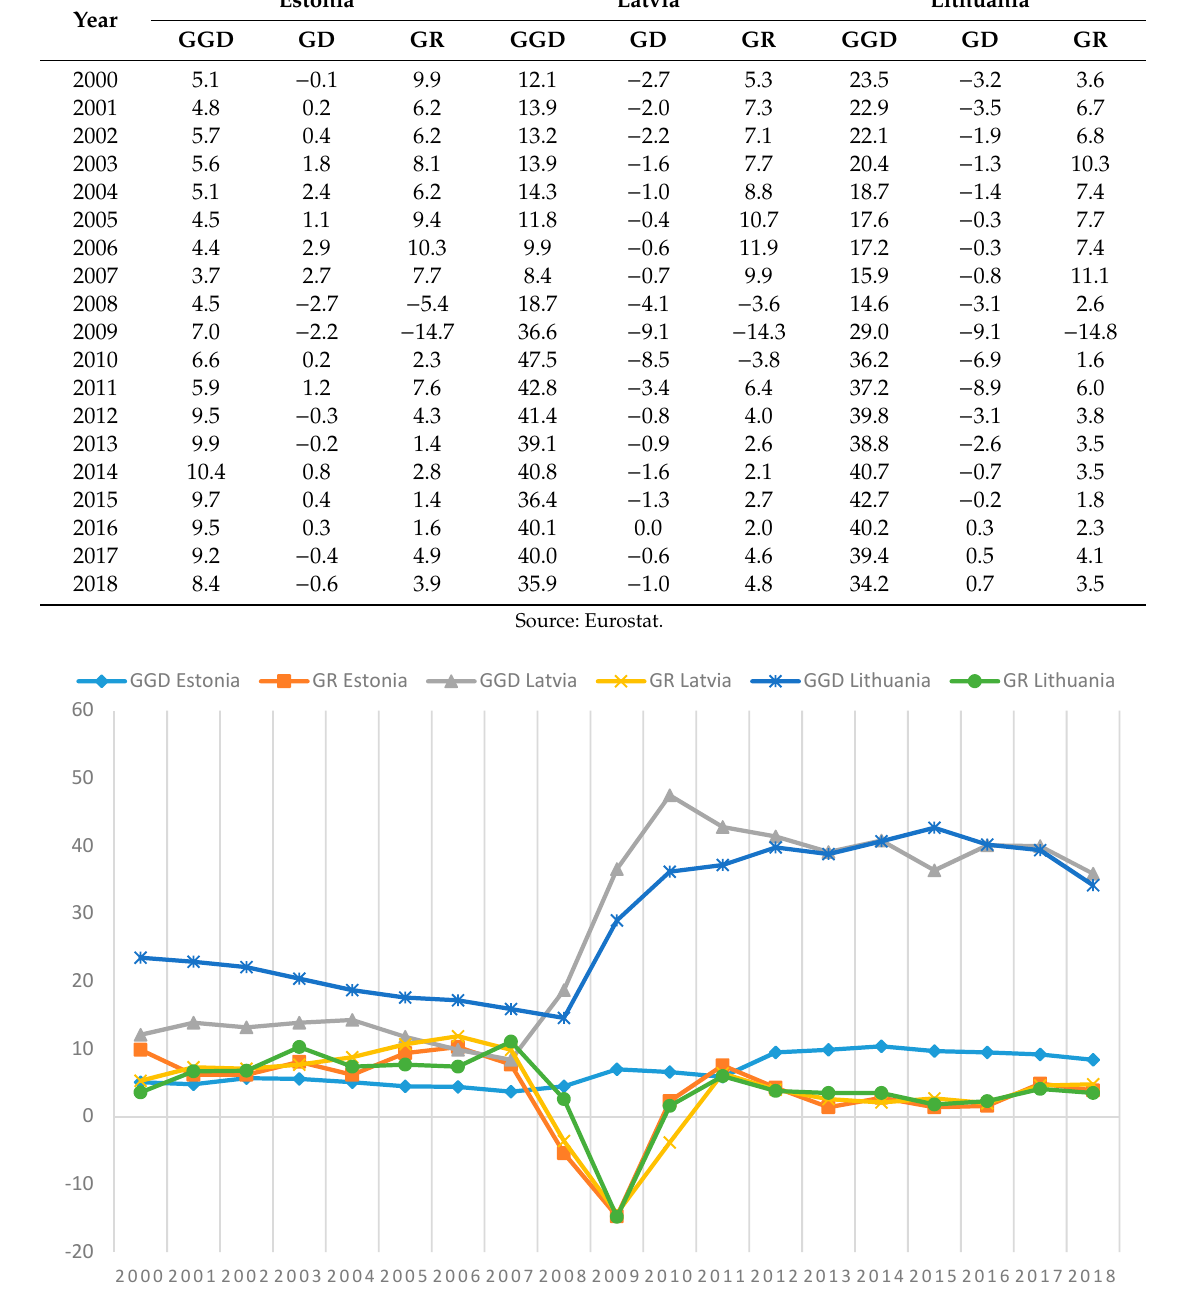
Figure 2. The Baltic countries’ GGD percentage of GDP versus growth rate percentage change from previous year, 2000–2018; Source: Eurostat.